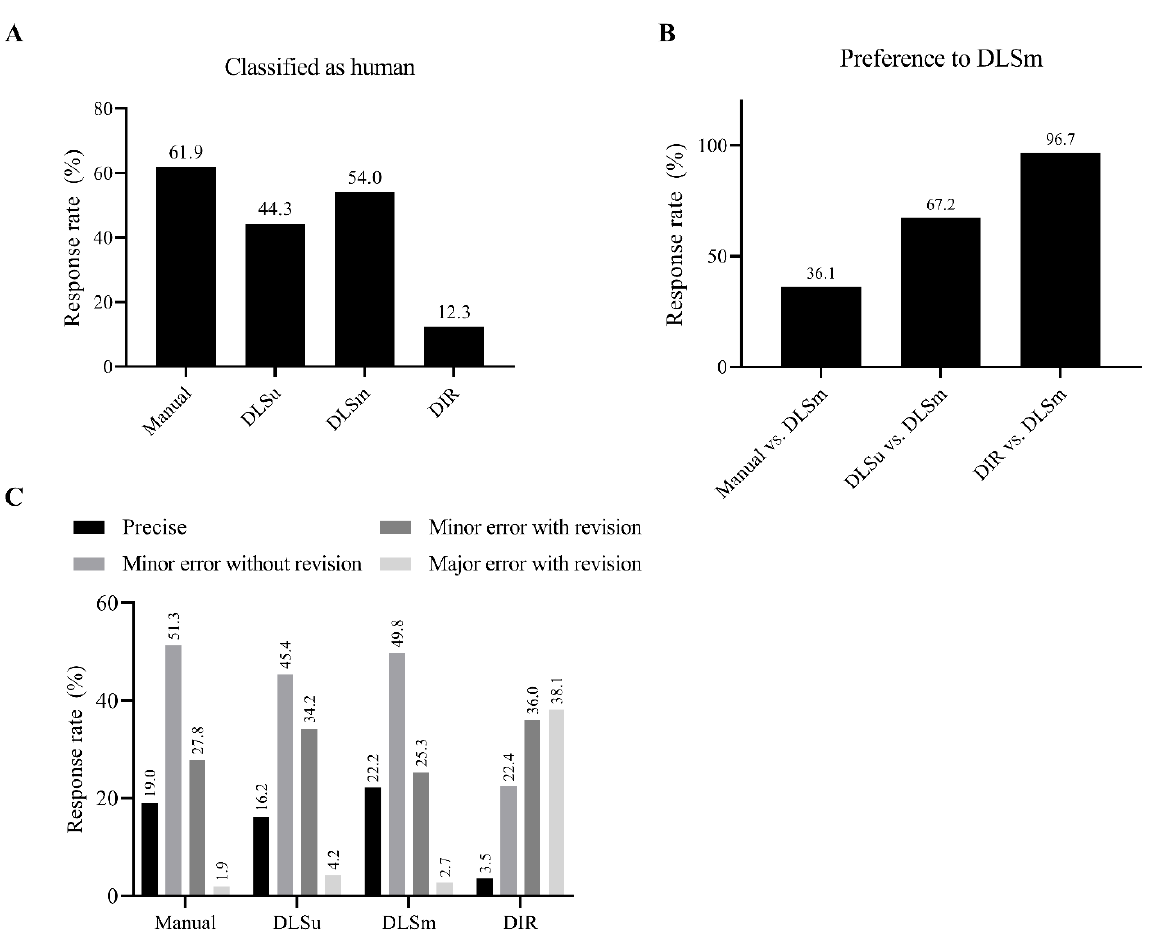
Figure 5. Subjective evaluation using the Turing test. The rate of discrimination of a single contour as having been generated by a human or a computer ( A ); comparison between two contours ( B ); quality assurance for review purposes of a single contour ( C ). Abbreviations: DLSu, deep learning-based segmentation using the unmatched training set; DLSm, deep learning-based segmentation using the matched training set; DIR, segmentation from deformable image registration.